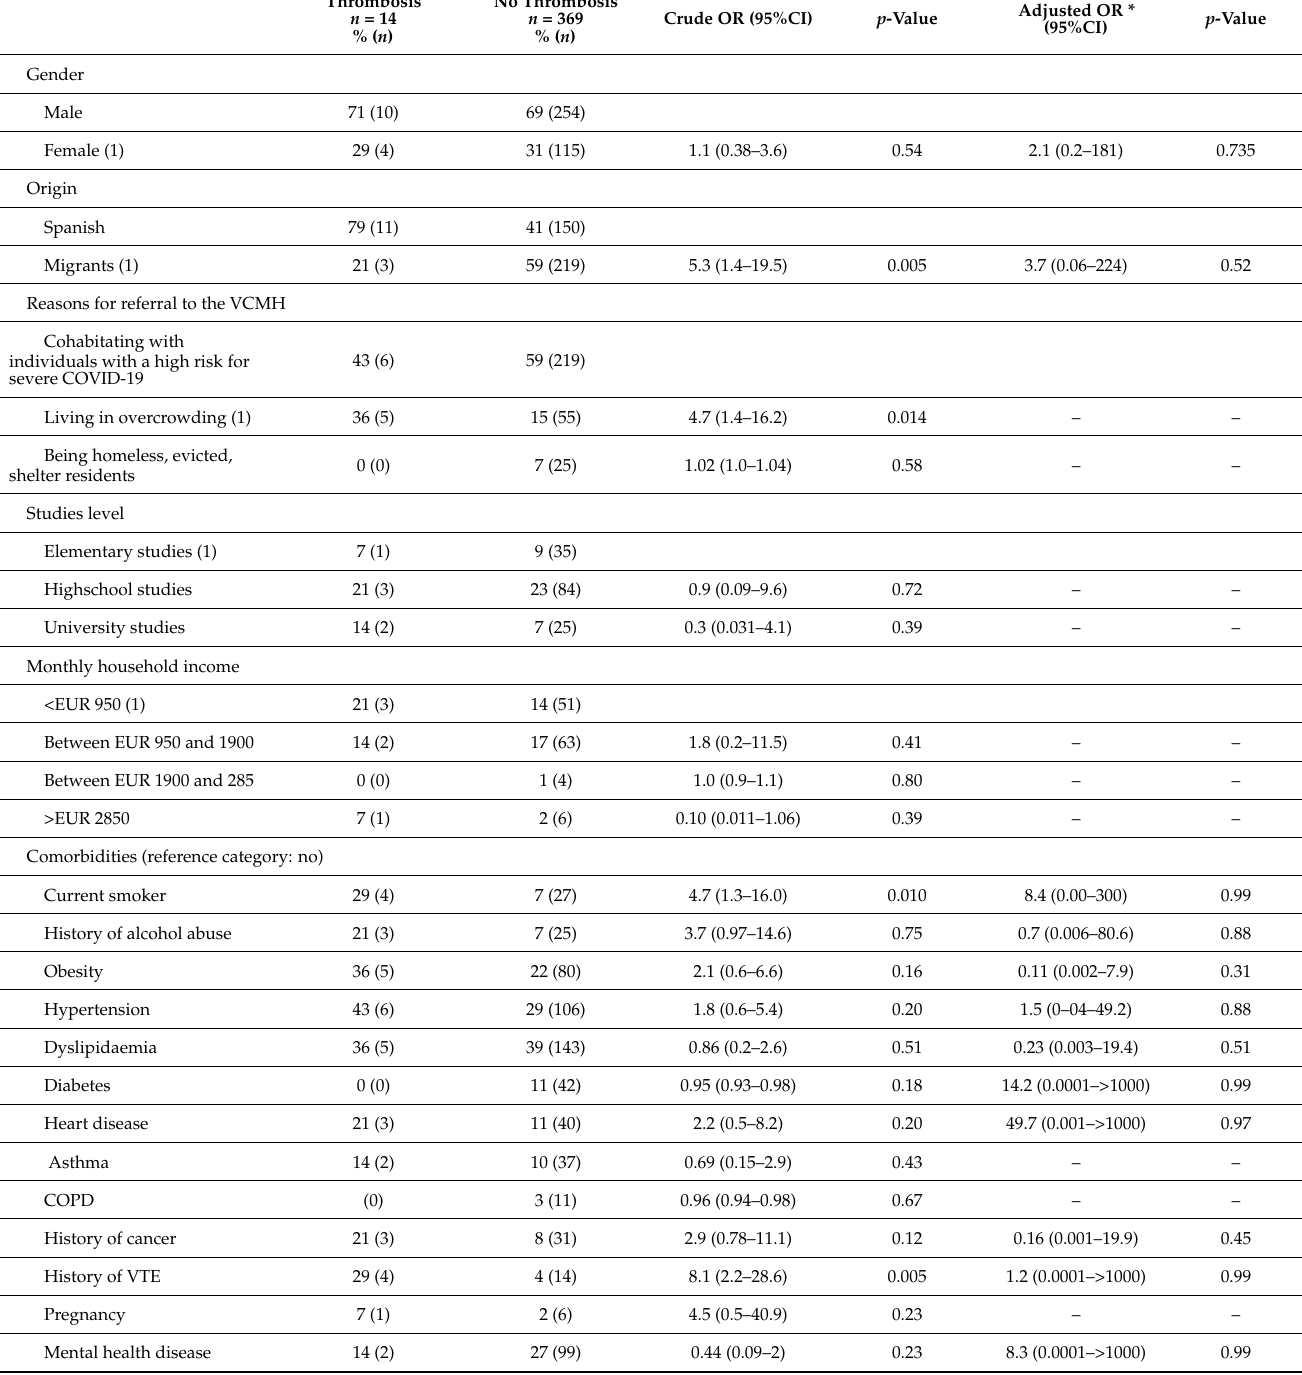
Table 2. Comparison between patients with and without